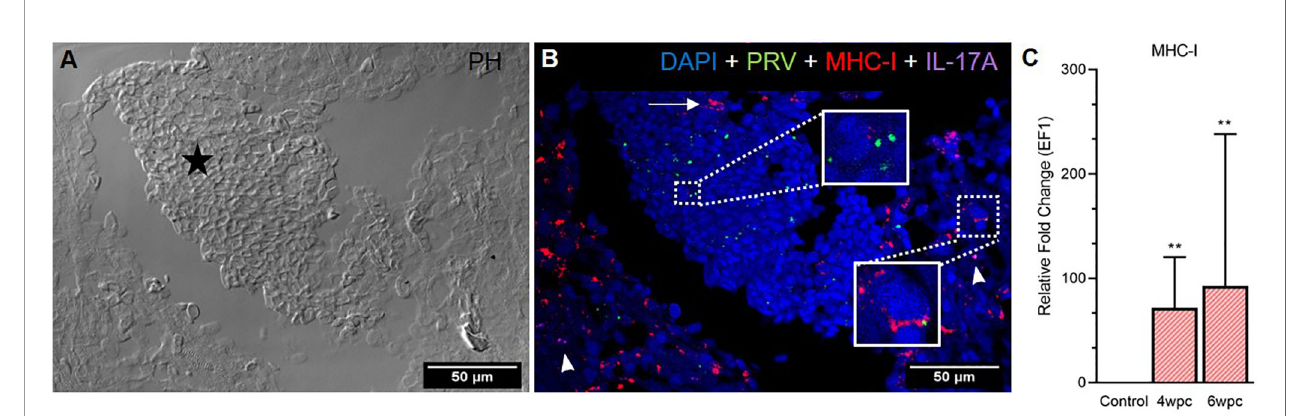
FIGURE 5 | Fluorescent in situ hybridization (FISH) of PRV-1, MHC-I and IL-17A in heart tissue at peak of HSMI (6 wpc). (A) Phase contrast image showing an area with aggregated blood cells (star) in the spongiosum layer. (B) Merged image showing presence of PRV-1 (green) in cardiomyocytes and clotted blood cells, partially co-localizing with MHC-I (red) positive cells (insets). Some MHC-I positive cells in the aggregated blood did not co-stain for PRV-1 (arrow). IL-17A (purple) positive cells were sporadically scattered in the tissue (arrowhead). Nuclei stained with DAPI (Blue) (Scale Bar = 50 µm). (C) Relative fold change expression (medians) of MHC-I at 4 wpc and 6 wpc normalized against EF1 a . Asterisk (*) shows signi fi cantly difference from the control (**p < 0.01).